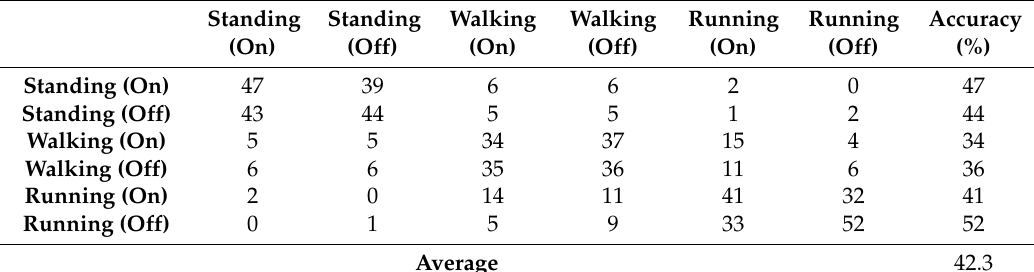
Table 2. Accuracy of SVMs for standing, walking, and running according to whether or not the safety helmet is worn properly.